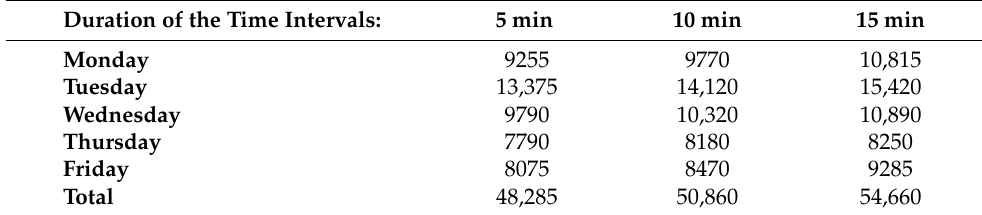
Table 3. Total waiting minutes obtained with the deterministic approach, using Model 1 for the ready times, with different durations of the considered time